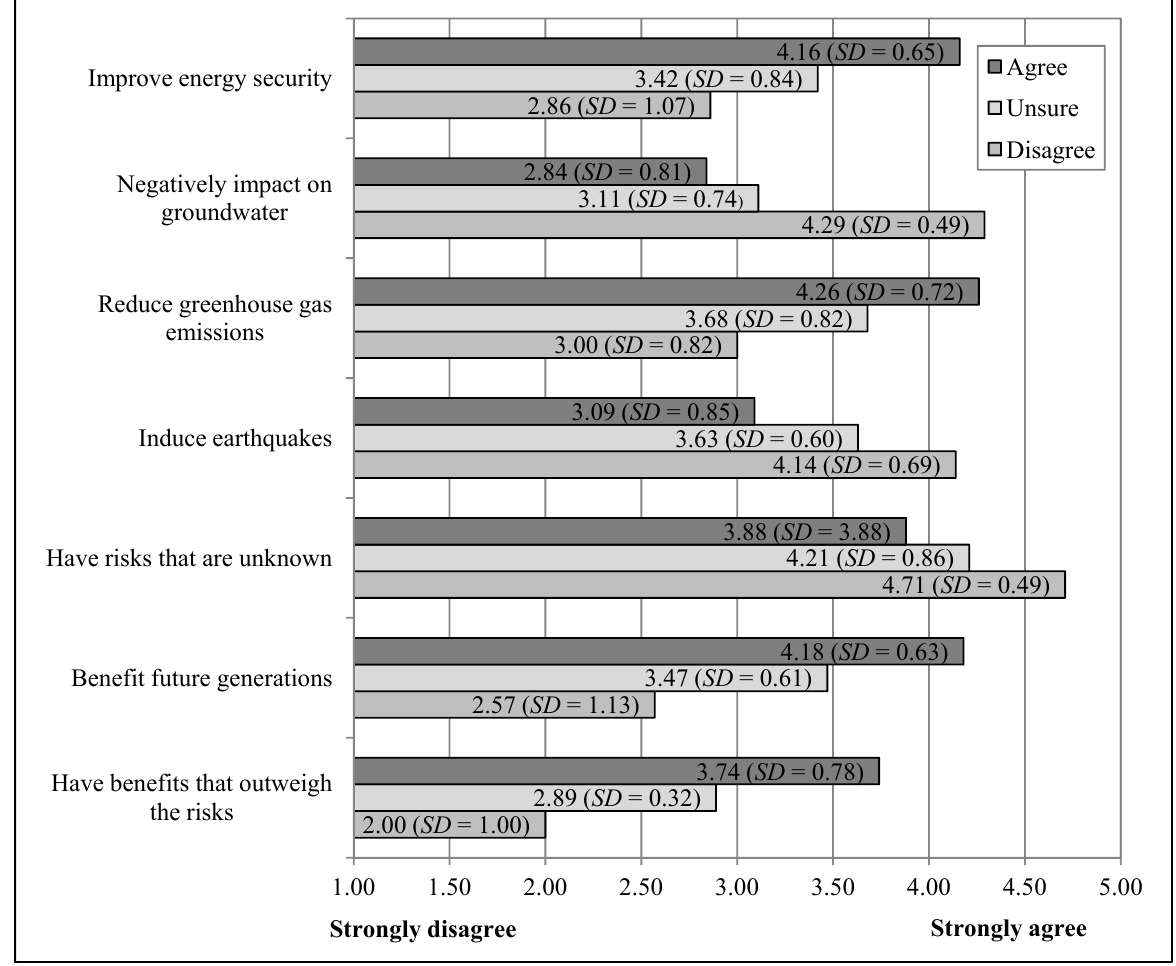
Figure 3. Mean ratings of benefit and risk statements by attitude group at the